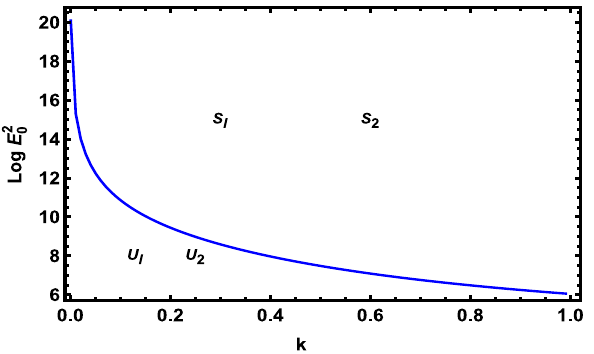
Figure 8. Deviation of log E 2 0 with k to illustrate the involvement of Eqs. (83) and